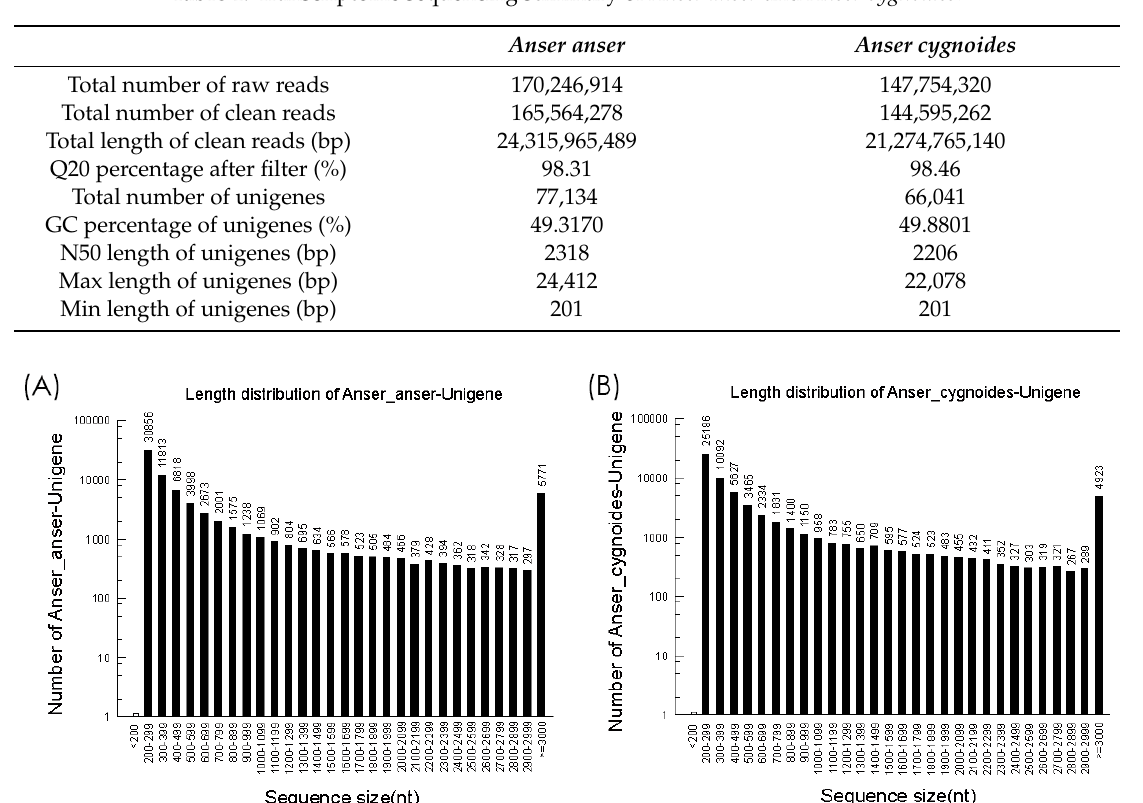
Table 1. Transcriptome sequencing summary of Anser anser and Anser cygnoides .